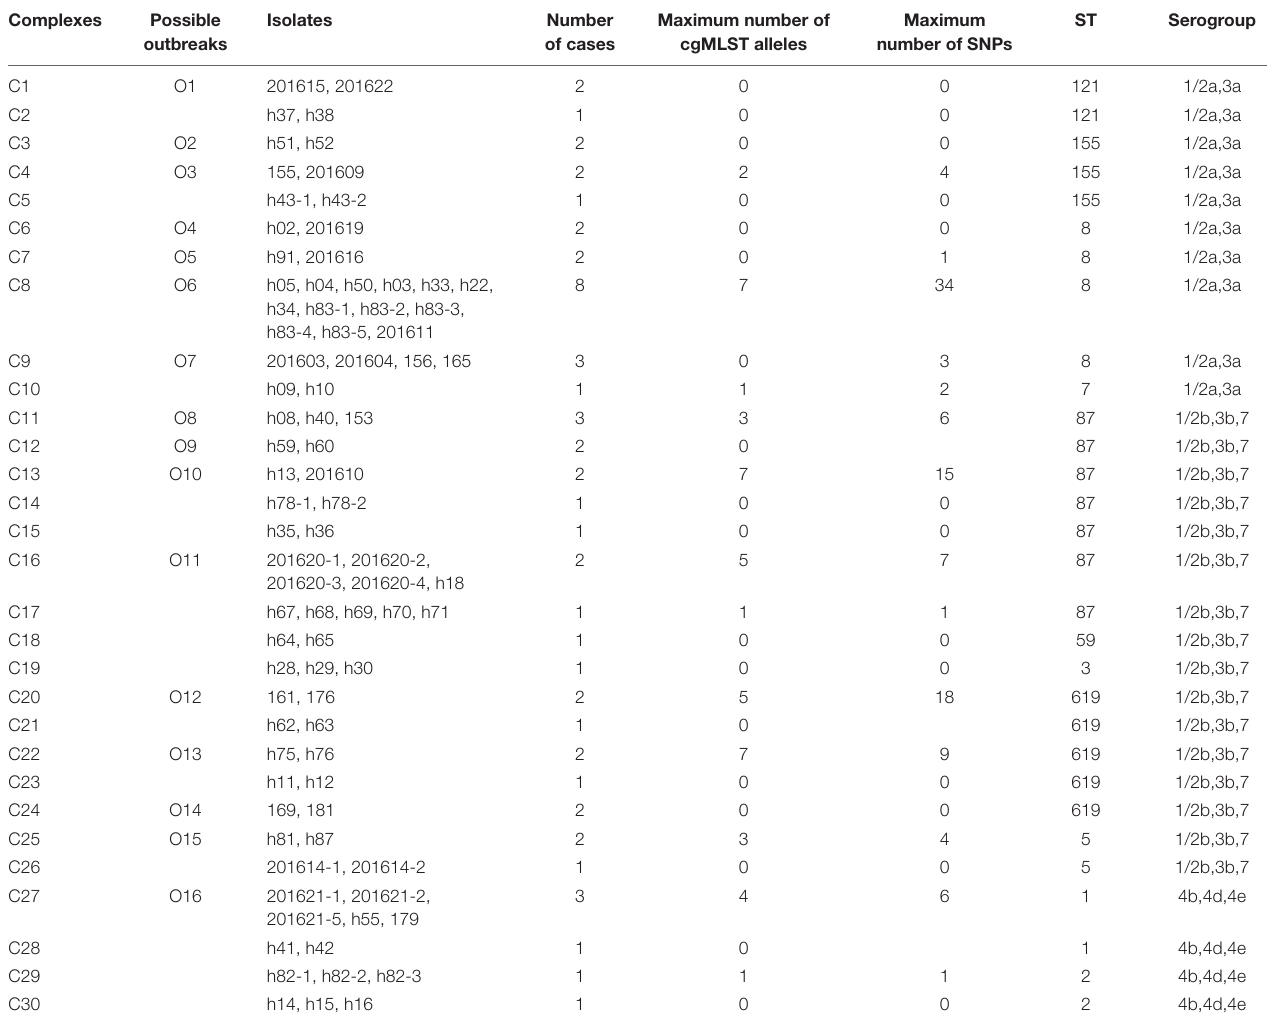
TABLE 2 | Relatedness of isolates as determined by cgMLST ( ≤ 7 different alleles). Complexes Possible Isolates Number outbreaks